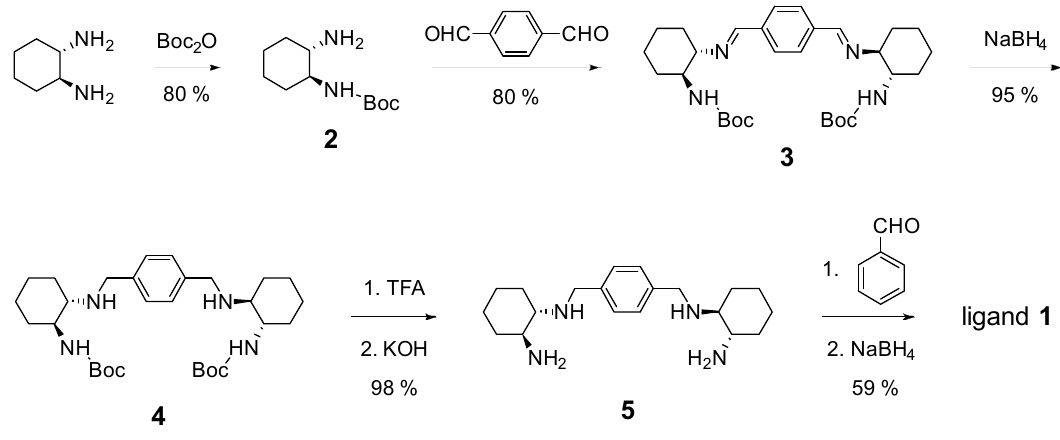
Scheme 1. Synthesis of ligand 1 .